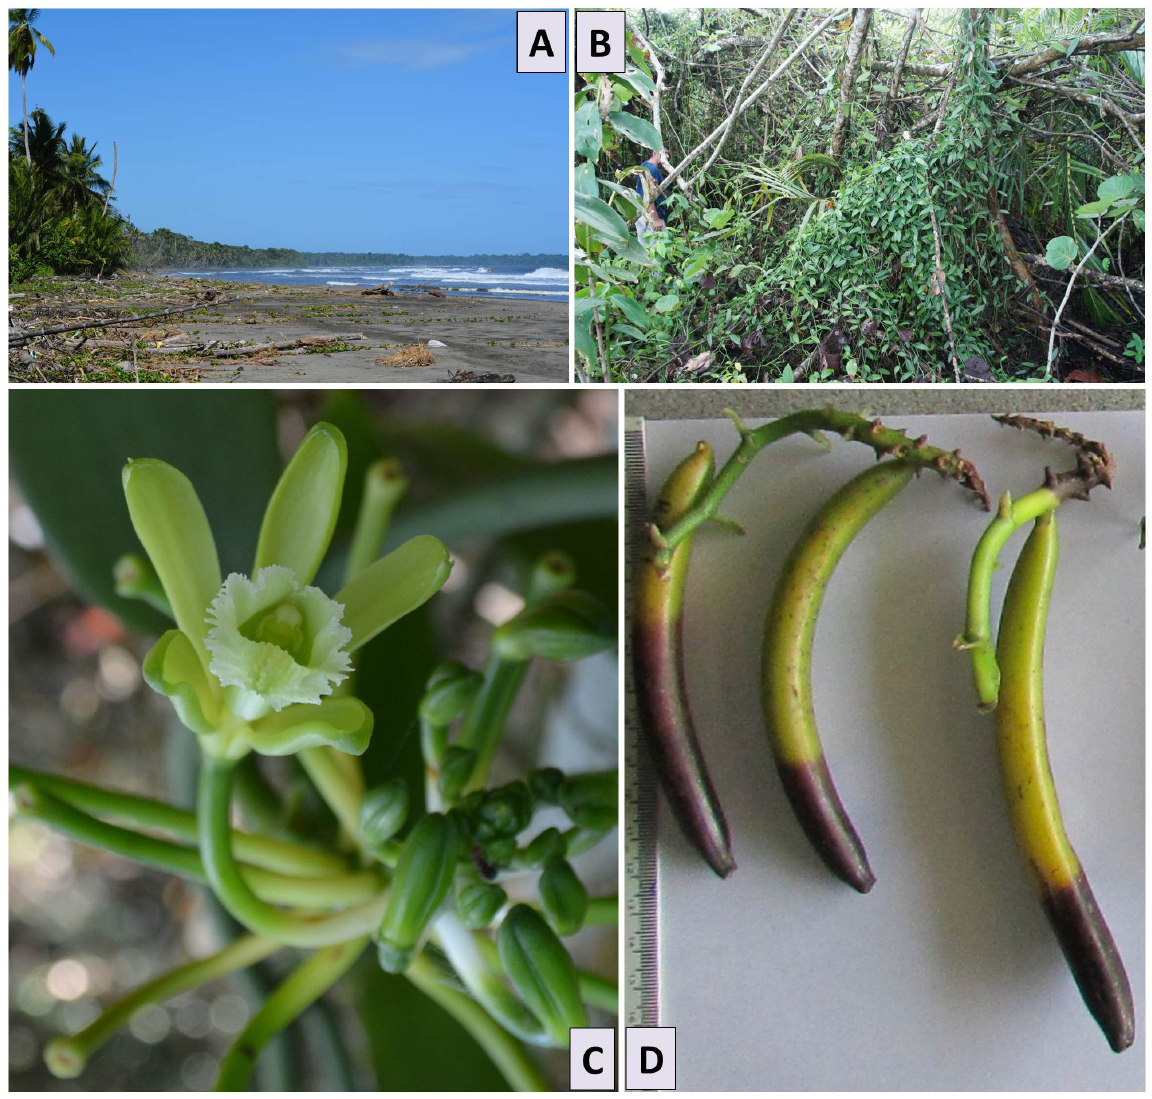
Fig. 2. Natural biotope of Vanilla sotoarenasii M.Pignal, Azofeifa-Bolaños & Grisoni sp. nov. (VanL) at Refugio Nacional Mixto de Vida Silvestre, Gandonca Manzanillo, Costa Rica. A . View of the